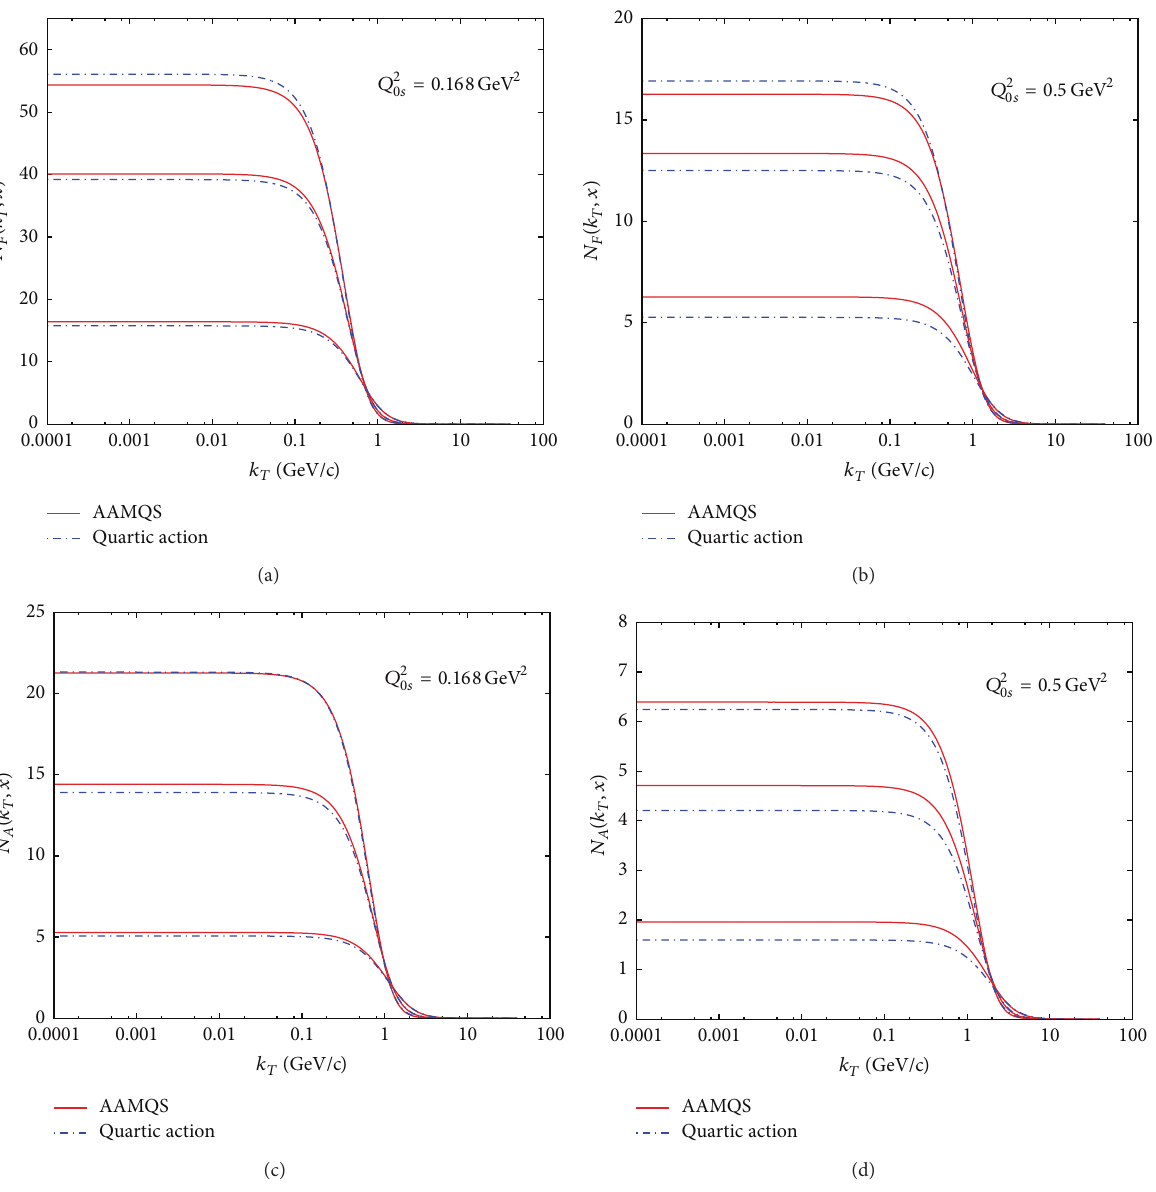
Figure 4: Dependence of the dipole scattering amplitude 𝑁 𝐴(𝐹) (𝑘 𝑇 ,𝑥) , the Fourier transform of 1 − N 𝐴(𝐹) (𝑟,𝑌) (15), on 𝑘 𝑇 for (a) a proton target and (b) a nucleus target with 𝐴 = 200 at different rapidities with two different initial conditions indicated in the figure. From the upper curve to the lowest one, the corresponding rapidities are 𝑦 = 2 , 4, and 8,